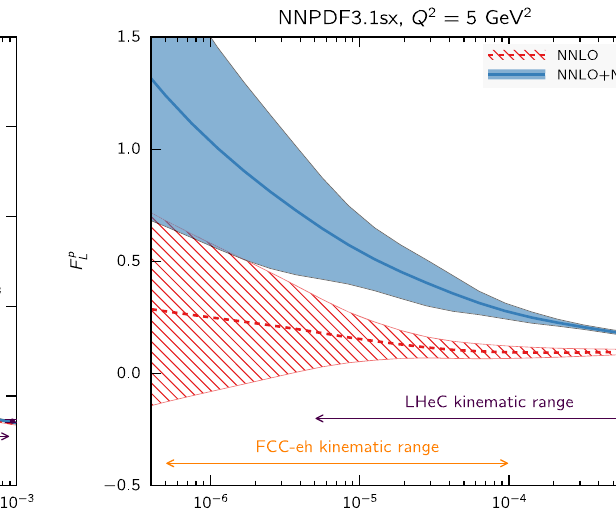
prediction. A small offset has been applied to the LHeC pseudo-data as some of the values of x overlap with the FCC-eh pseudo-data points. The inset in the left plot shows a magnified view in the kinematic region x > 3 × 10 − 5 , corresponding to the reach of HERA data